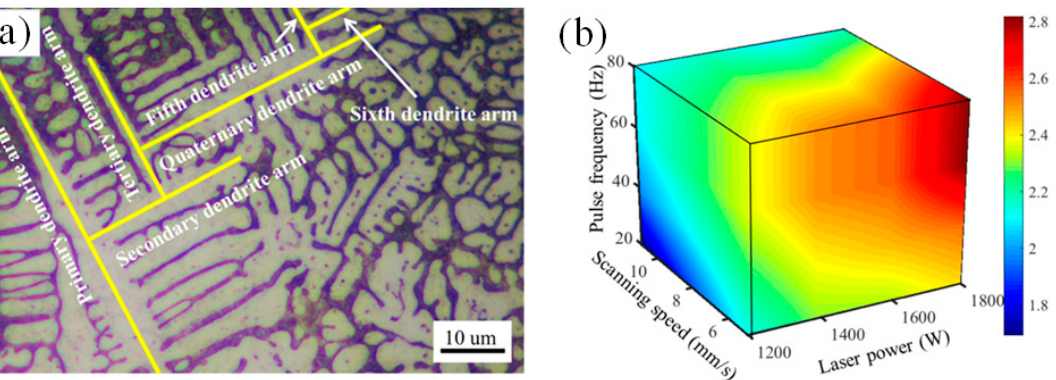
Figure 6. ( a ) From primary- to sixth- dendrite arm, and ( b ) Secondary dendrite arm spacing (SDAS) values map for single track deposition of high-nitrogen steel. (Reprinted from ref. [27], copyright (2019), with permission from Elsevier).